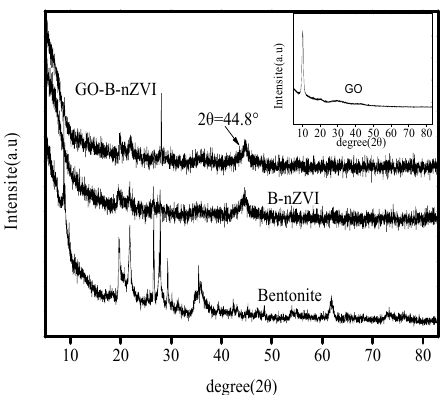
Figure 2. X-ray diffraction analysis (XRD) patterns of bentonite, B-nZVI, GO-B-nZVI, and GO.